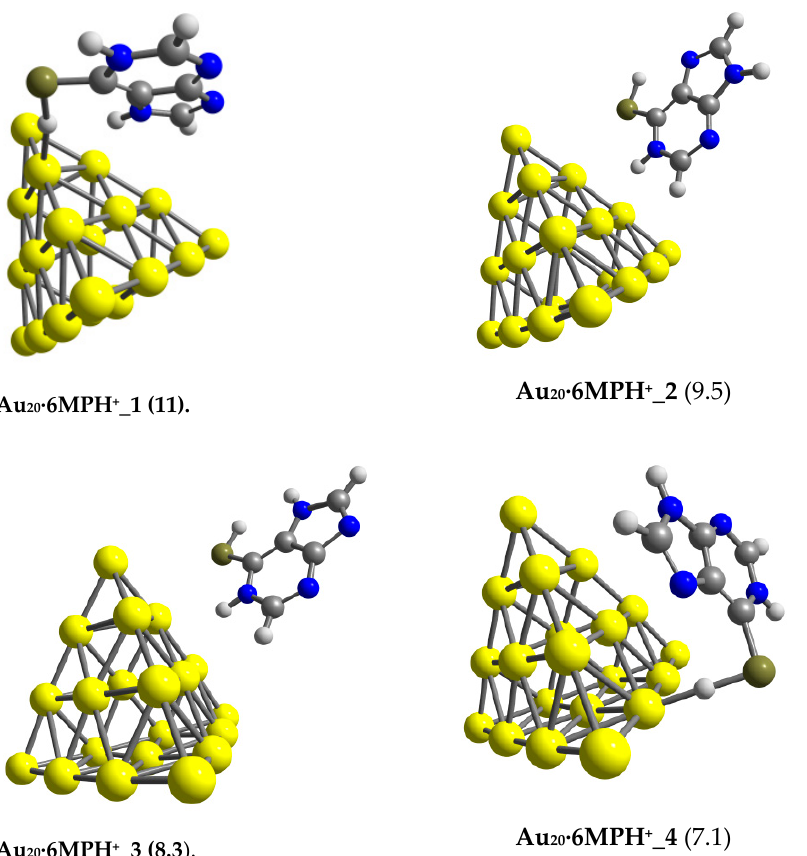
Figure 5. Lower-lying structures of the Au 20 · 6MP complexes in an acidic environment. Values in parentheses are binding energies (kcal/mol, PBE/cc-pVTZ/pVDZ-PP + ZPE). The yellow, gray, blue, lime, and white balls represent Au, C, N, S and H atoms, respectively.